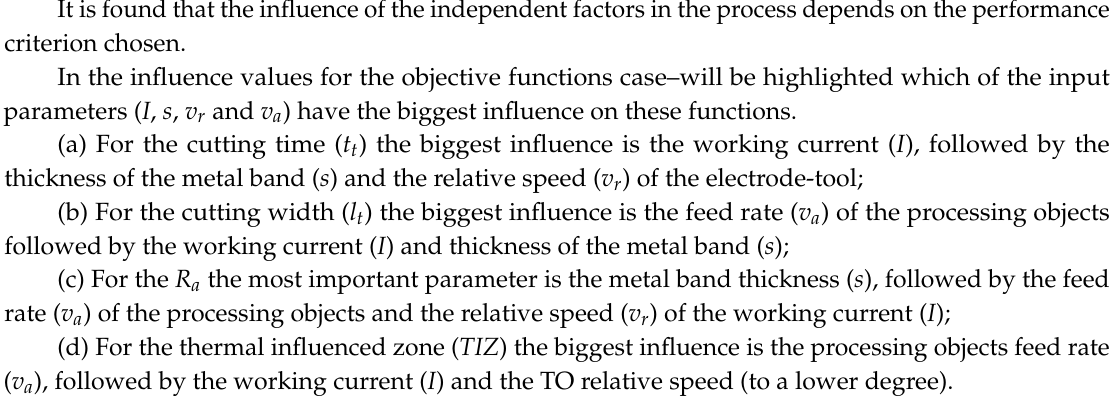
Figure 13. Thermal influenced zone values measured [mm].